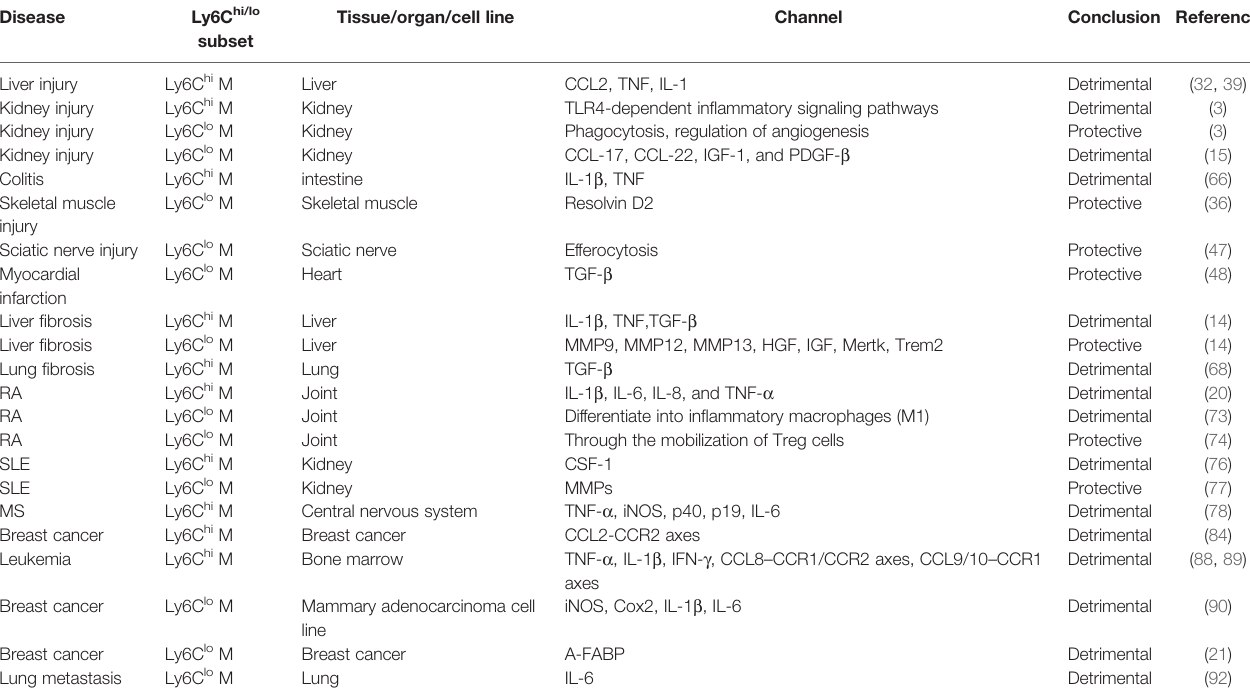
TABLE 1 | The role of Ly6C hi/lo macrophages in disease.